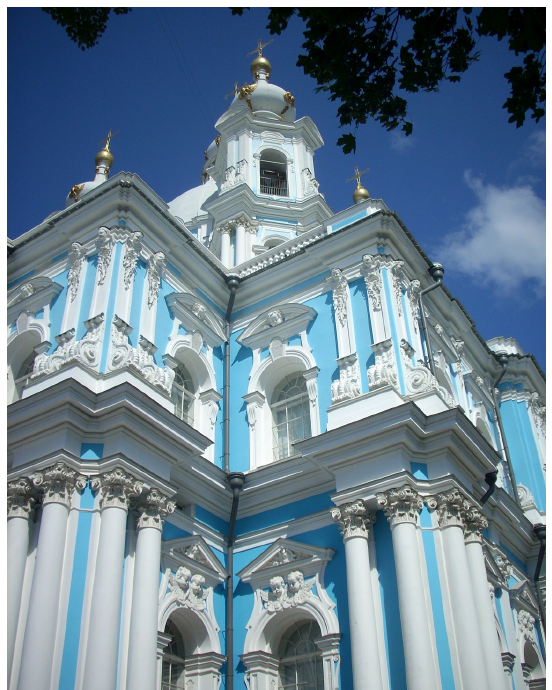
Figure 18. Despite the ahistorical color, the polychromatic distinction of the vertical structure was preserved. The Smolny Cathedral in St. Petersburg (1748–1764). Photo from private collection.